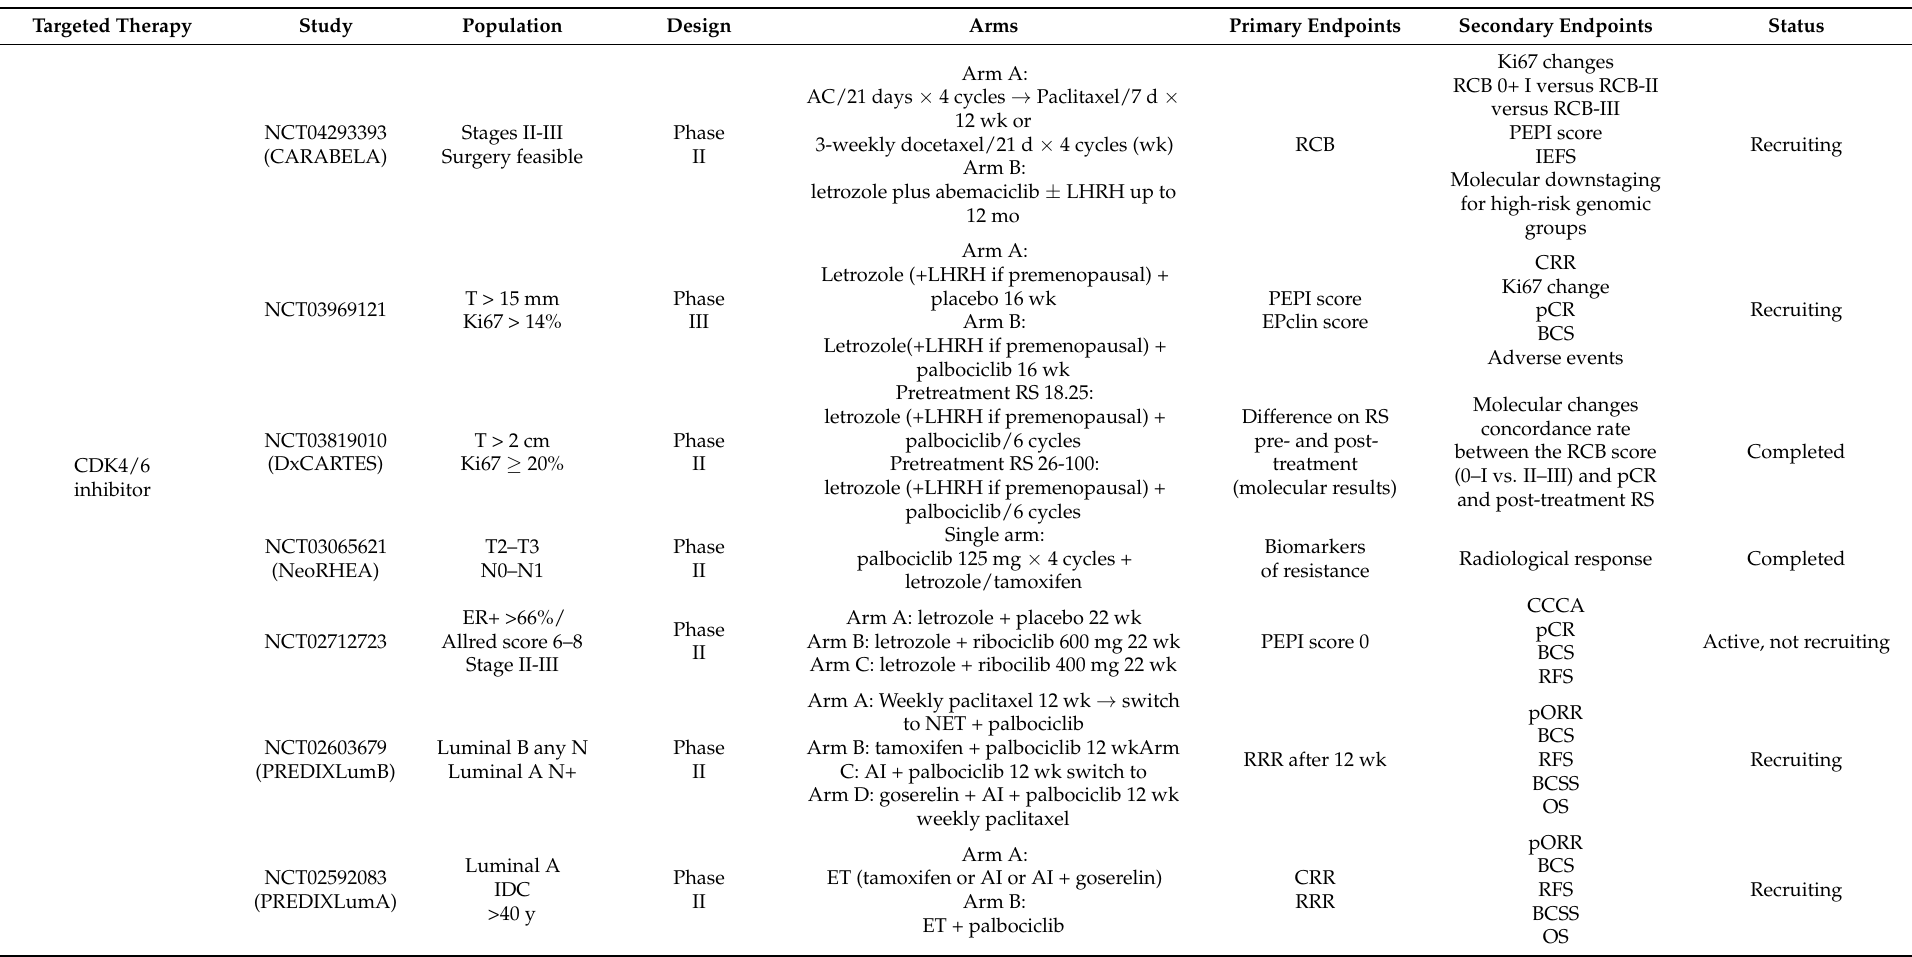
Table 6. Ongoing Trials with targeted